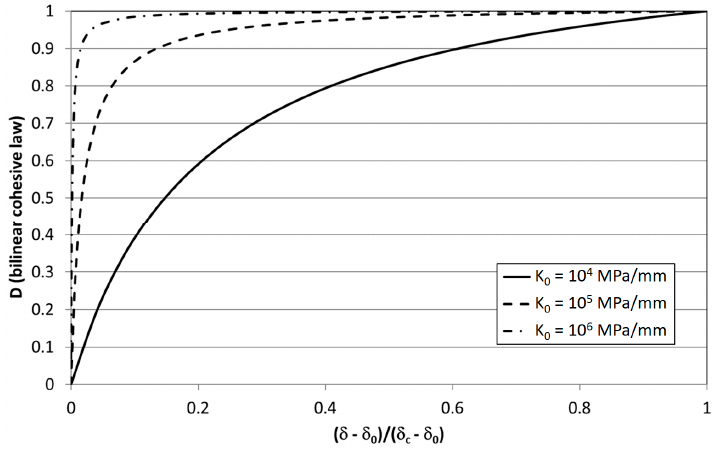
Figure 2. Evolution of quasi-static damage, Equation (1), for different values of K 0 and σ 0 = 30 MPa.